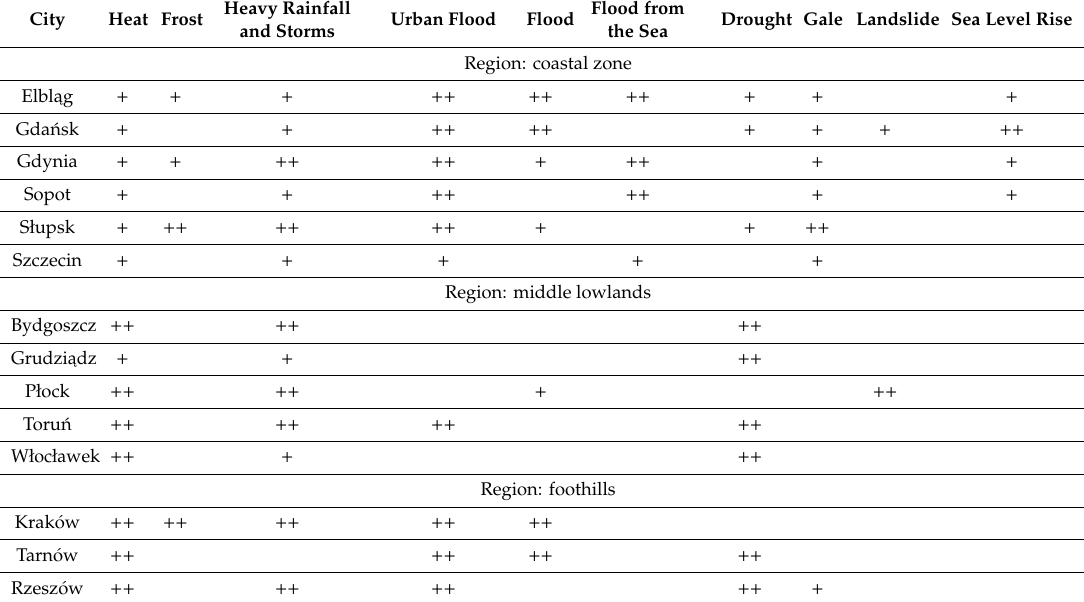
Table 3. Main climate phenomena that pose a climate risk in selected cities in Poland (based on the MAPs of 14 cities up to